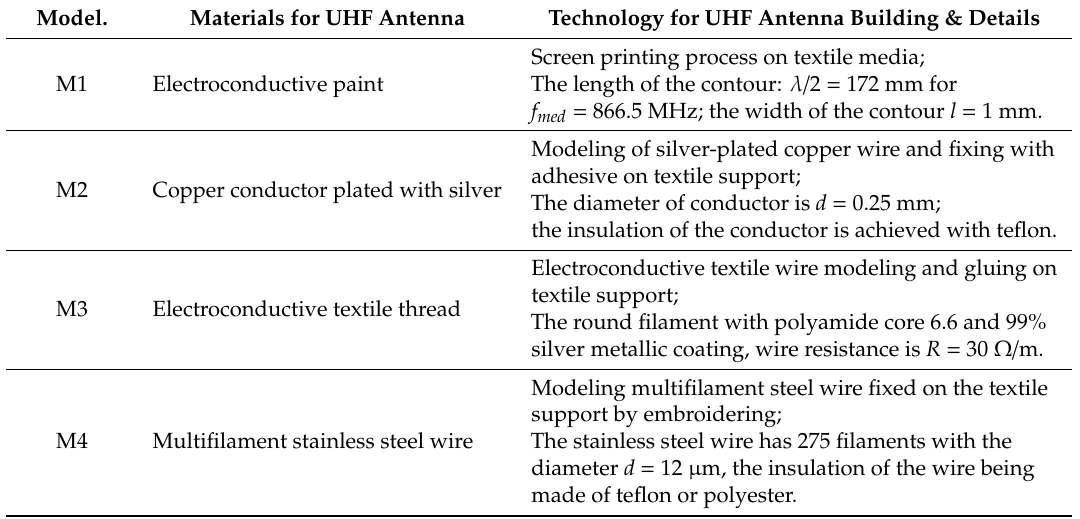
Table 2. Passive RFID tag models and materials and technologies for building UHF antennas.